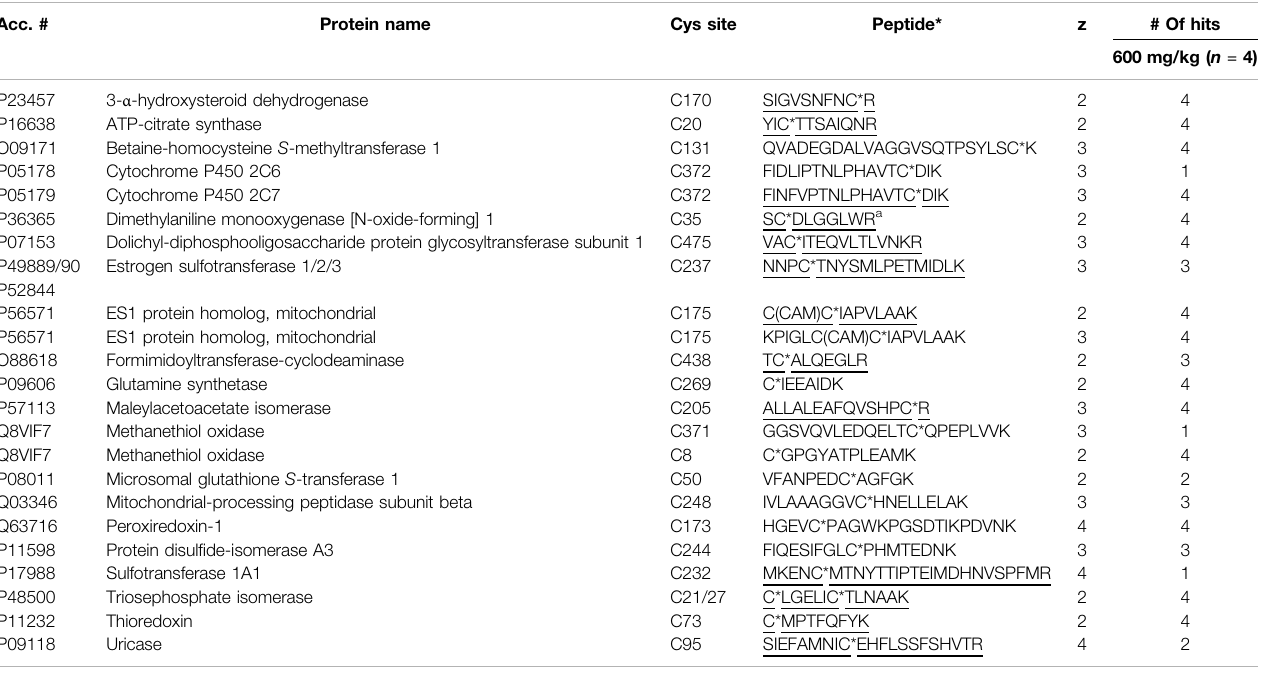
TABLE 3 | Identi fi ed APAP-modi fi ed peptides in rat liver via LC-MRM. Acc.